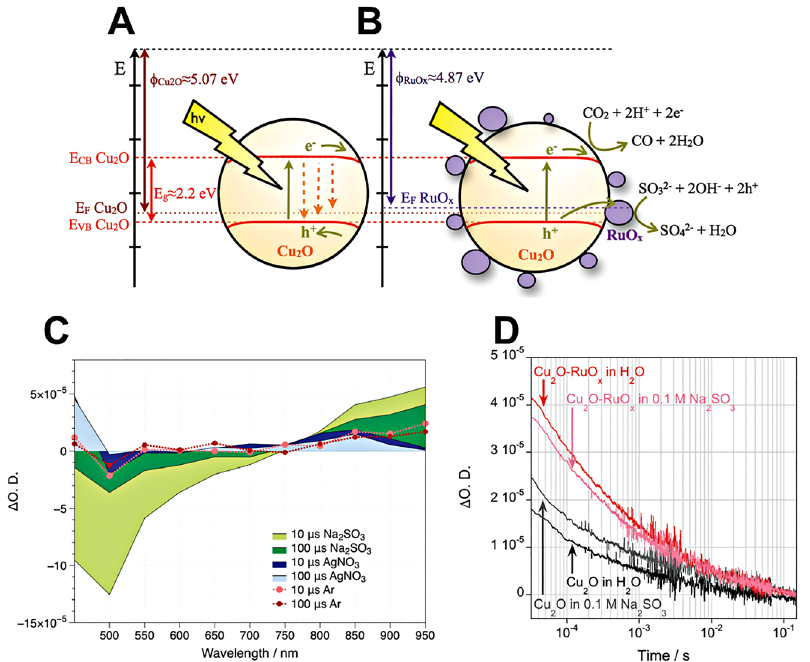
which would hinder the oxidation reaction. As depicted in Figure 8A, the overall photocatalytic performance is then restrained by electron – hole recombination induced by trapped photoholes. To achieve practical use of Cu photocatalysts, appropriate surface modi fi cation to mediate interfacial charge dynamics is indispensable.